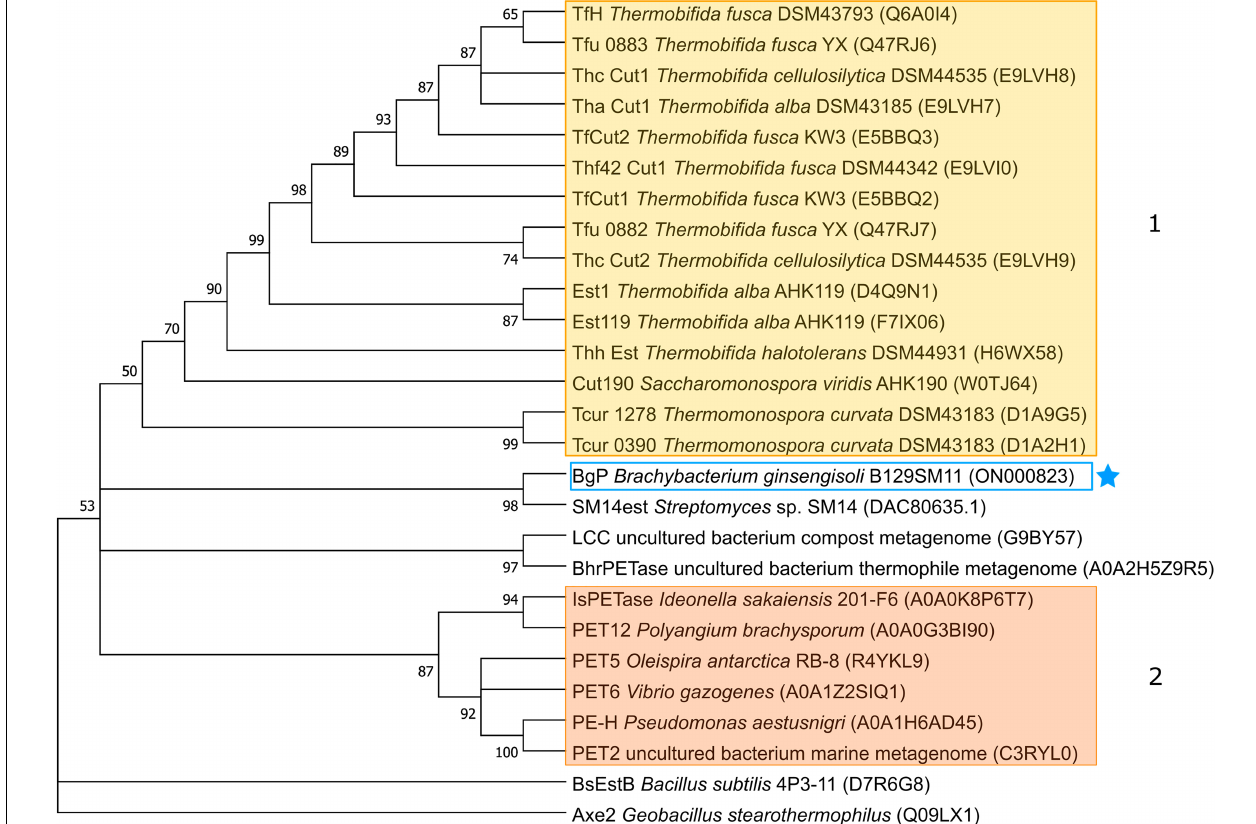
Frontiers in Microbiology |